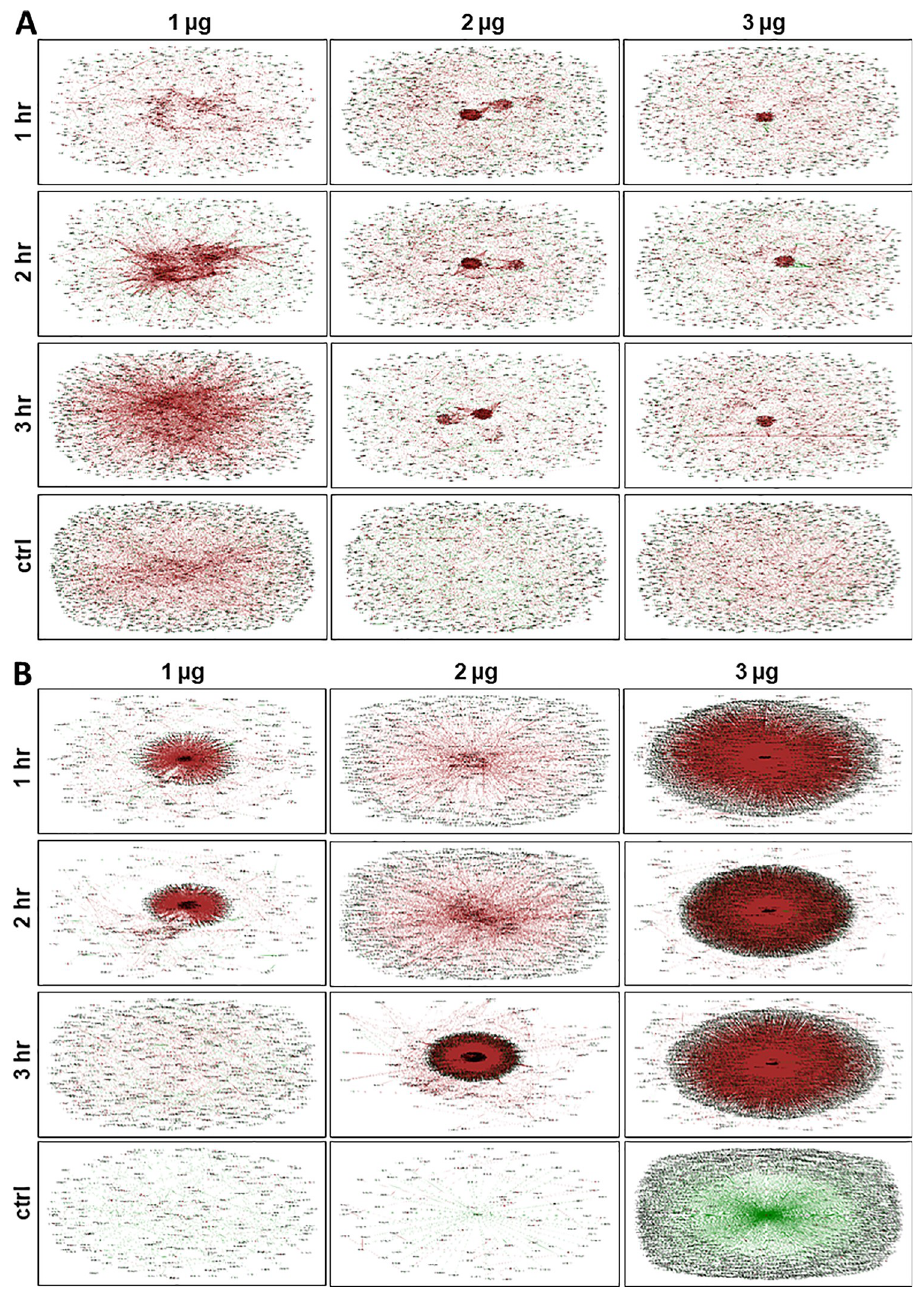
Fig 6. Models of transcriptional co-expression networks constructed for E . coli (A) and L . monocytogenes (B), based on co-expression under control (untreated), and 1 hr, 2 hr, and 3 hr exposure to different doses of O 3 . Each node represents a gene and each line denotes the expression correlation between the two nodes. Green node denotes upregulated genes; blue node denotes downregulated genes; brown line denotes positively correlated genes by Pearson Correlation Coefficient (PCC); green line denotes negatively correlated genes by